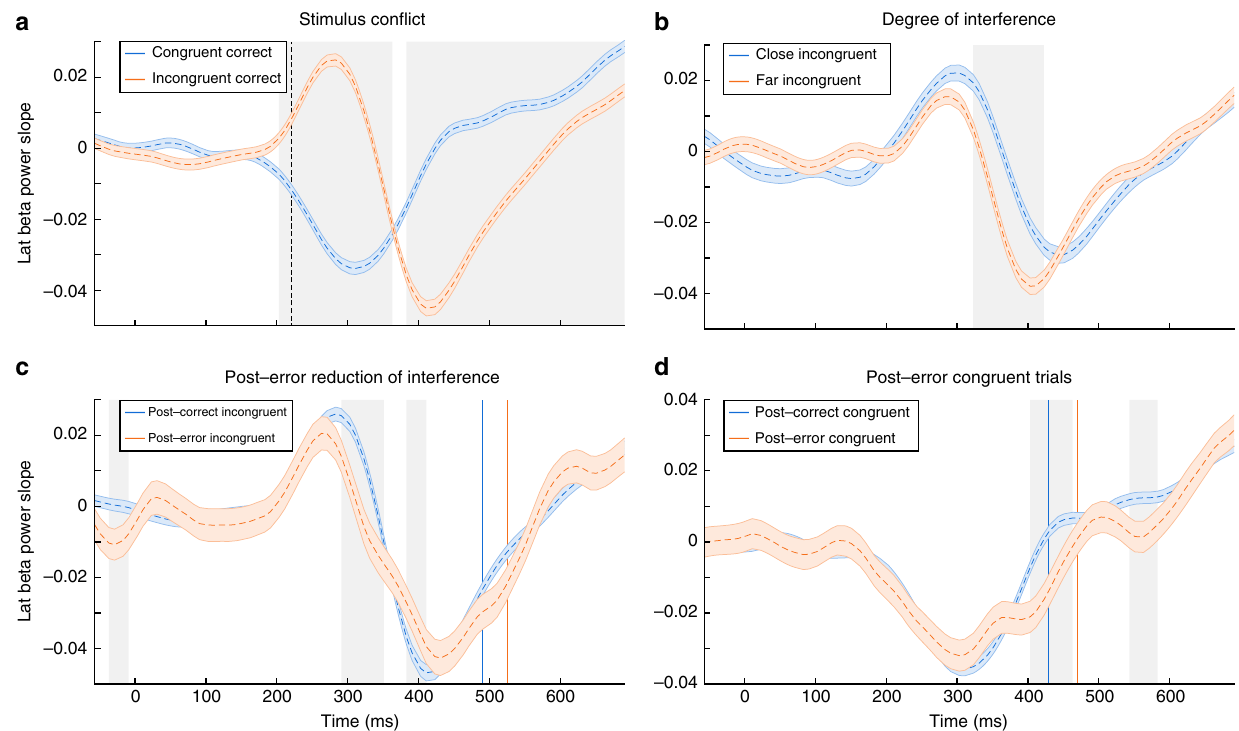
Fig. 8 Beta slope dissociates speci fi c from general adaptations. BPL slope indexes the steepness of the BPL signal analysed via single-trial fi tting of individual periods in the BPL signal surrounding every data point (80 ms). The slope can be seen as the rate of change in BPL, thus re fl ecting how quickly beta power lateralises to one hemisphere. a Displays how BPL slopes differ between congruent (blue) and incongruent (orange) trials. The dashed vertical line re fl ects when BPL slopes start to fi rst signi fi cantly deviate from zero, which coincides with the non-decision time parameter in the DDM. b Displays that the degree of interference induced by visual proximity of the distractors affects the duration of BPL slopes that point into the incorrect (distractor-) direction. As a result, when incongruent fl ankers are close to the target, BPL to the wrong direction is stronger and longer-lasting as compared to far fl anker trials (cf. Supplementary Figure 6). Similarly, for incongruent trials the slope of distractor processing is in fl uenced by previous accuracy ( c ), which is consistent with PERI. However, there is no signi fi cant difference (even at a very lenient threshold of p < 0.05) at any point during early BPL slopes when comparing congruent post-error (orange) to post-correct (blue) trials. This suggests that post-error trials speci fi cally reduce the interference induced by distractors, which is seen in the BPL slope analysis at around 290 to 360 ms. For an additional analysis comparing how slow and fast responses are associated with BPL slope, see Supplementary Figure 8. Statistical comparisons between conditions are calculated via repeated t -tests corrected for multiple comparisons ( a , b ) or uncorrected ( c , d ), and signi fi cant time periods are shaded in grey re fl ecting